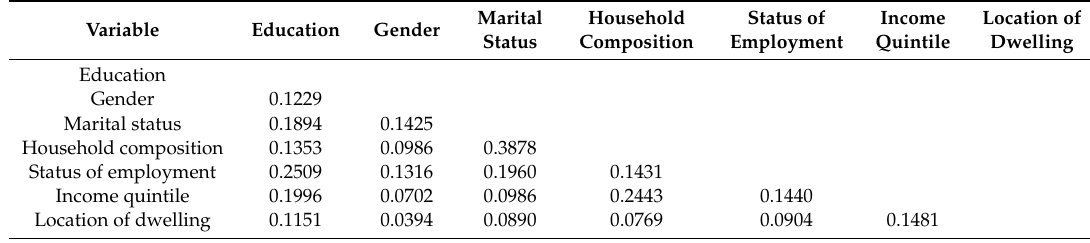
Table A3. Values of the Cramer’s V measure for 2018–2019